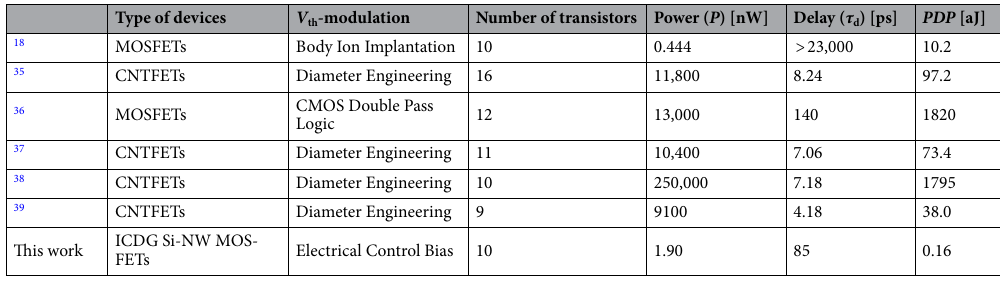
Table 2. Benchmarking table of ternary logic